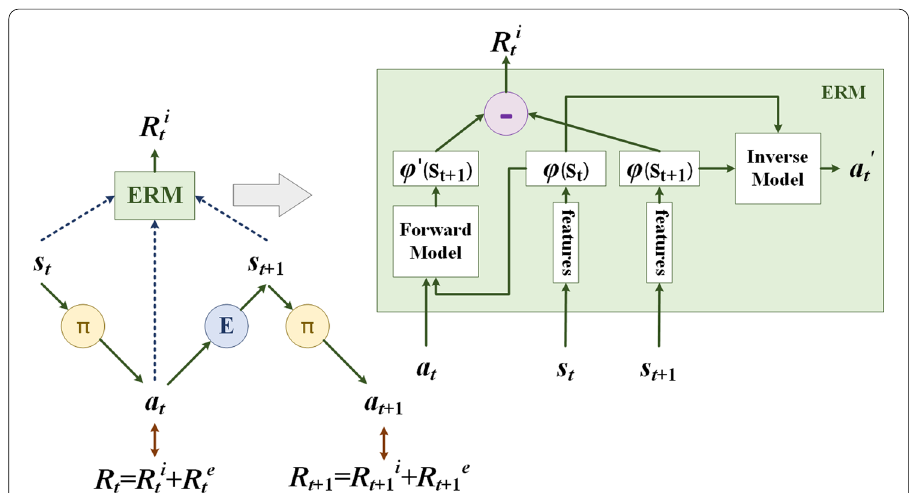
Fig. 2 Structure of the internal reward mechanism